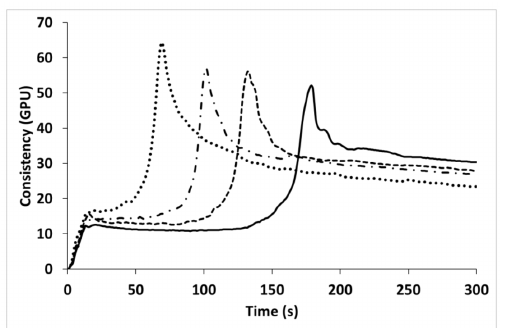
Figure 1. Gluten aggregation properties of wheat (solid line), and with increasing replacement level of cricket powder (5%: dashed line; 10%: dash–dotted line; 20%: dotted line). GPU—GlutoPeak